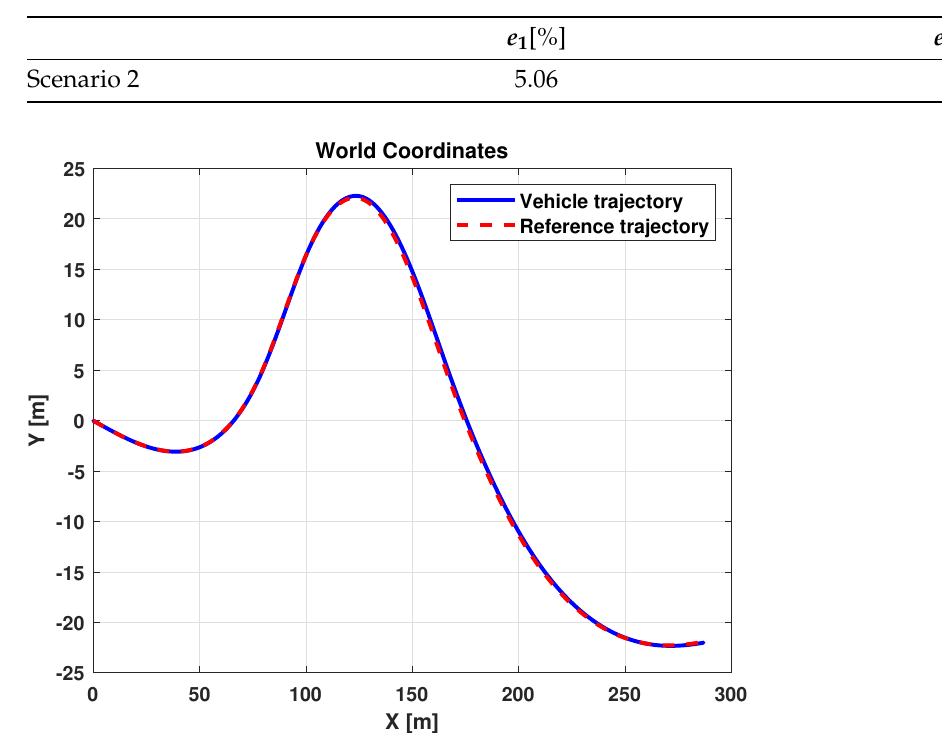
Table 4. Scenario 2: relative errors.